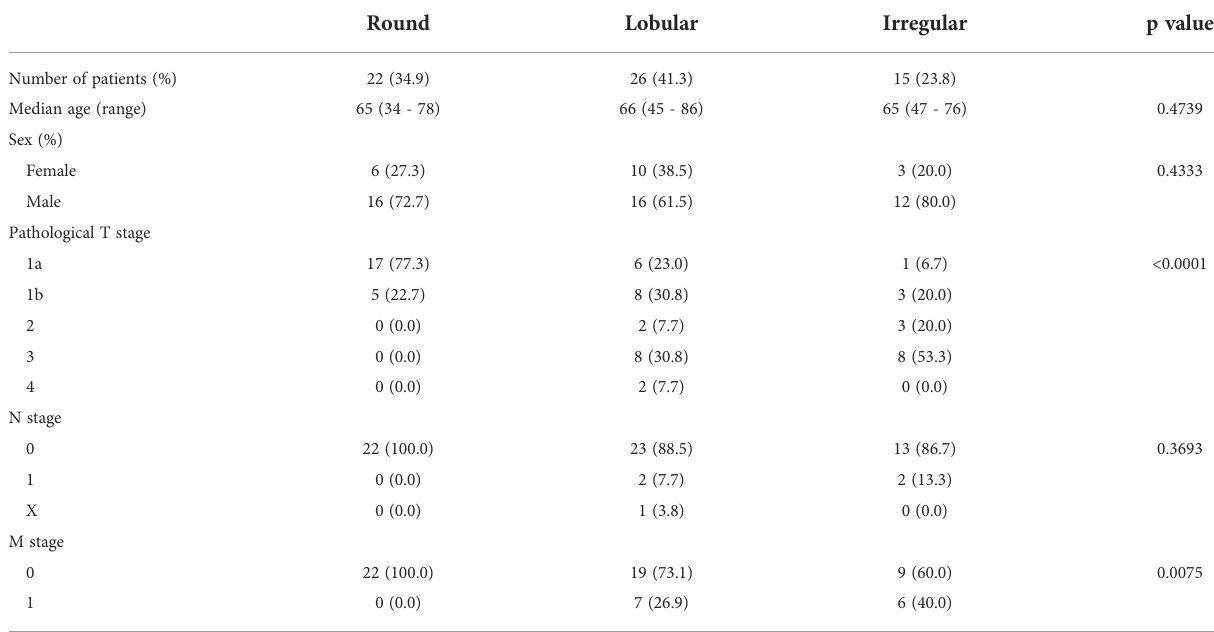
TABLE 3 Patient background comparison for each morphological classi fi cation of ccRCC in our